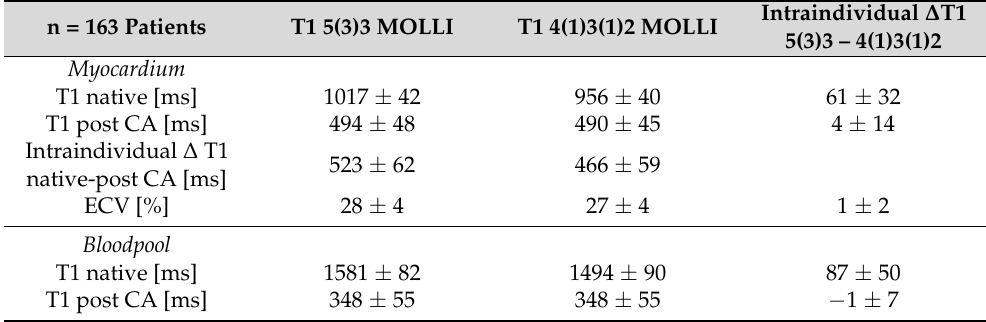
Table 3. T1 mapping in all patients.